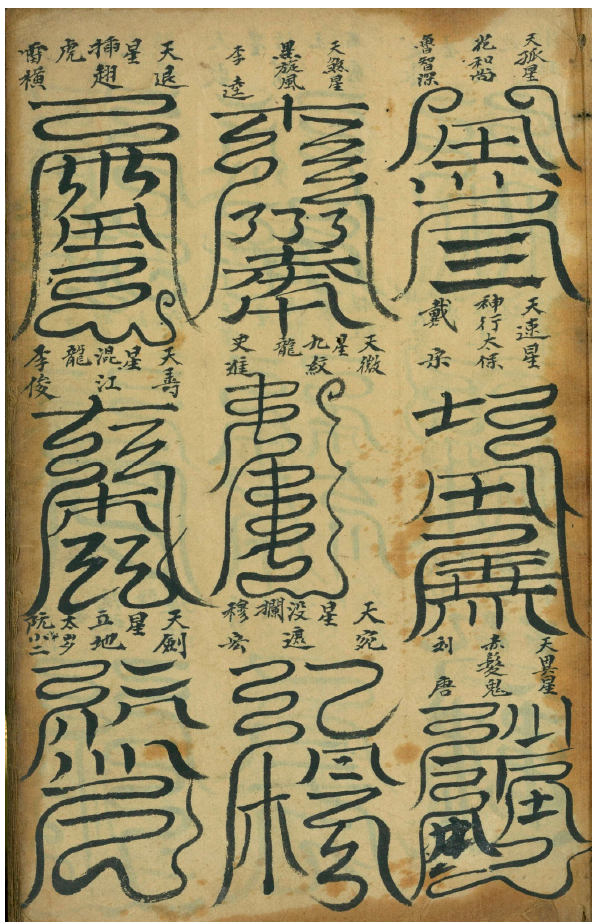
Figure 3. One page of the Li County manual, including several of the most famous heroes from Watermargin , such as Lu Zhishen, Li Kui, Shi Jin and so on. 50 新 授 嗣 徒弟 子 召 將 運 用 秘 訣 (10a). 51 The pages are 6 recto , 6 verso